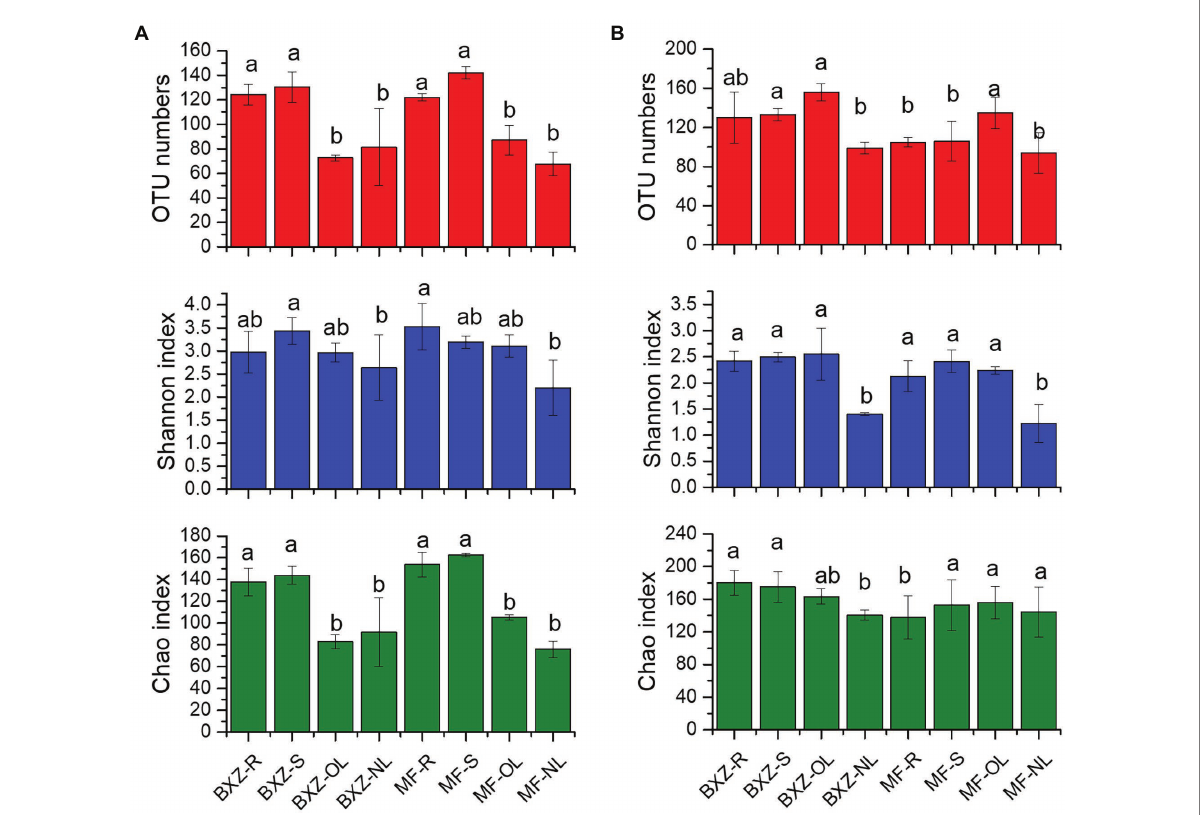
FIGURE 1 Diversity of endophytic bacteria (A) and fungi (B) in tea trees. BXZ_R, BXZ_S, BXZ_OL 556 and BXZ_NL represented root, stem, old leave and new leave samples of BXZ cultivar, while MF_R, 557 MF_S, MF_OL and MF_NL represented root, stem, old leave and new leave samples for MF cultivar.